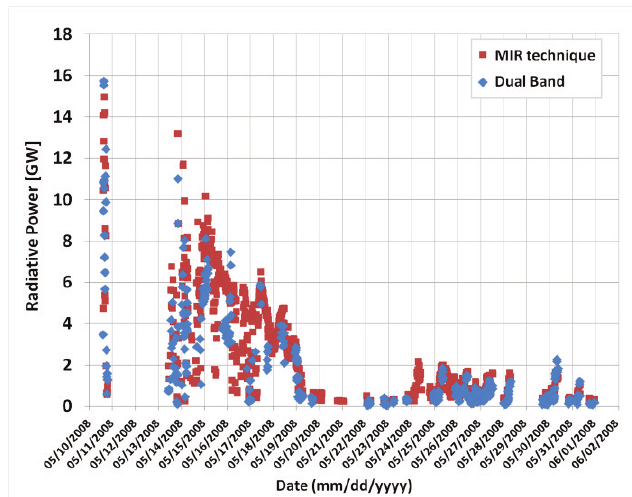
Figure 4. Radiative power computed by the MIR radiance technique (red) and by the dual-band three-component technique (blue) for the SEVIRI data during May,